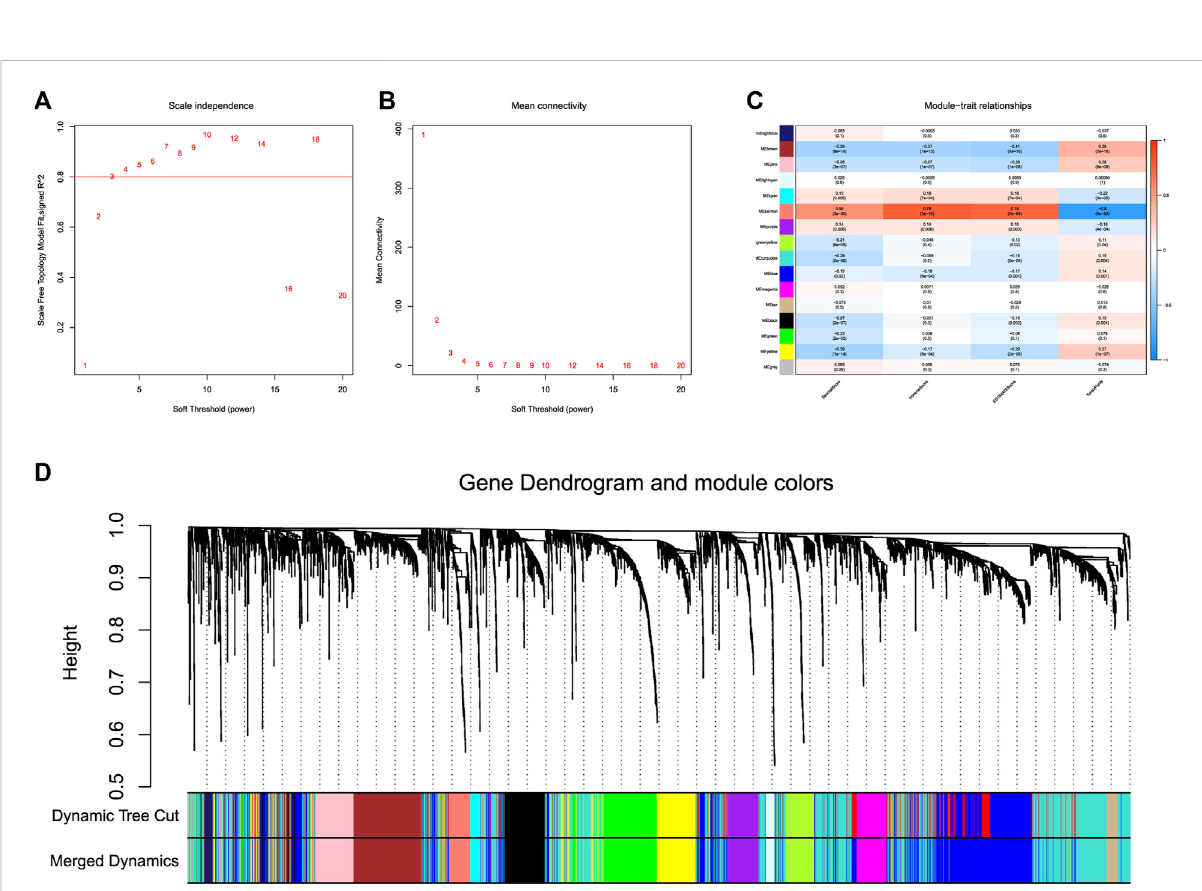
FIGURE 2 WGCNA of lncRNAs in HCC. (A) The scale-free fi t index for different softthresholding powers is analyzed. (B) Analysis of the mean connectivity for different soft-thresholding powers. (C) ImmuneScore and its inter-module correlations shown as a heatmap. (D) Clustering dendrogram of 369 hepatocellular carcinoma